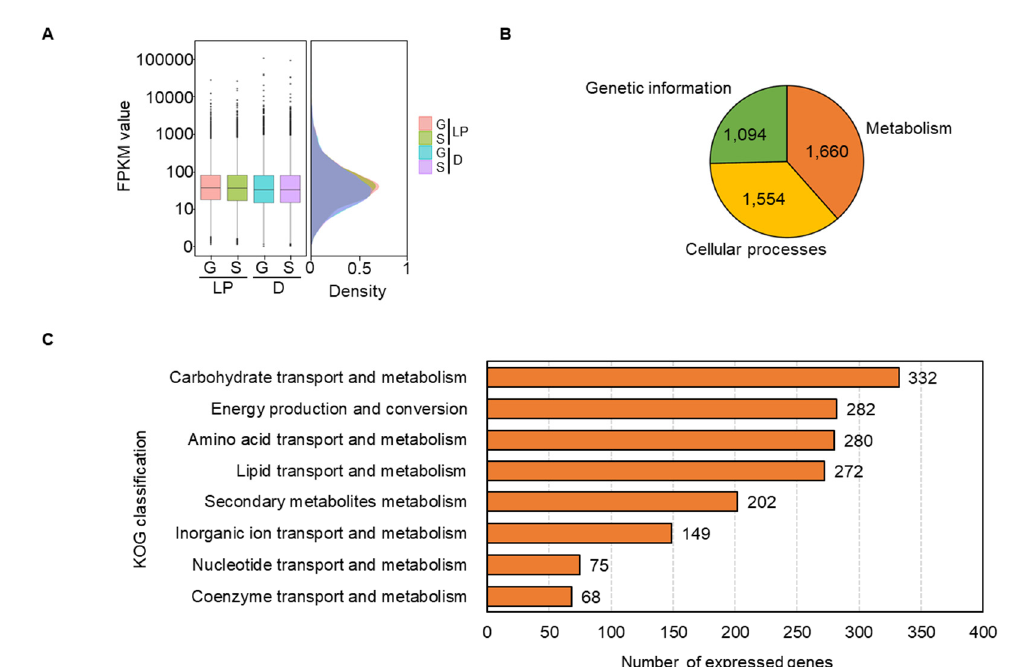
Figure 2. Assessed transcriptome data of C. militaris cells grown at di ff erent cultivation conditions. ( A ) Box plot and histogram of the FPKM distribution of the glucose (G) and sucrose (S) cultures grown at the light-programming (LP) and dark (D) conditions. ( B ) Functional categories of C. militaris TBRC6039 transcriptome using the KOG database. ( C ) Metabolic functional categories of expressed genes based on the KOG database.